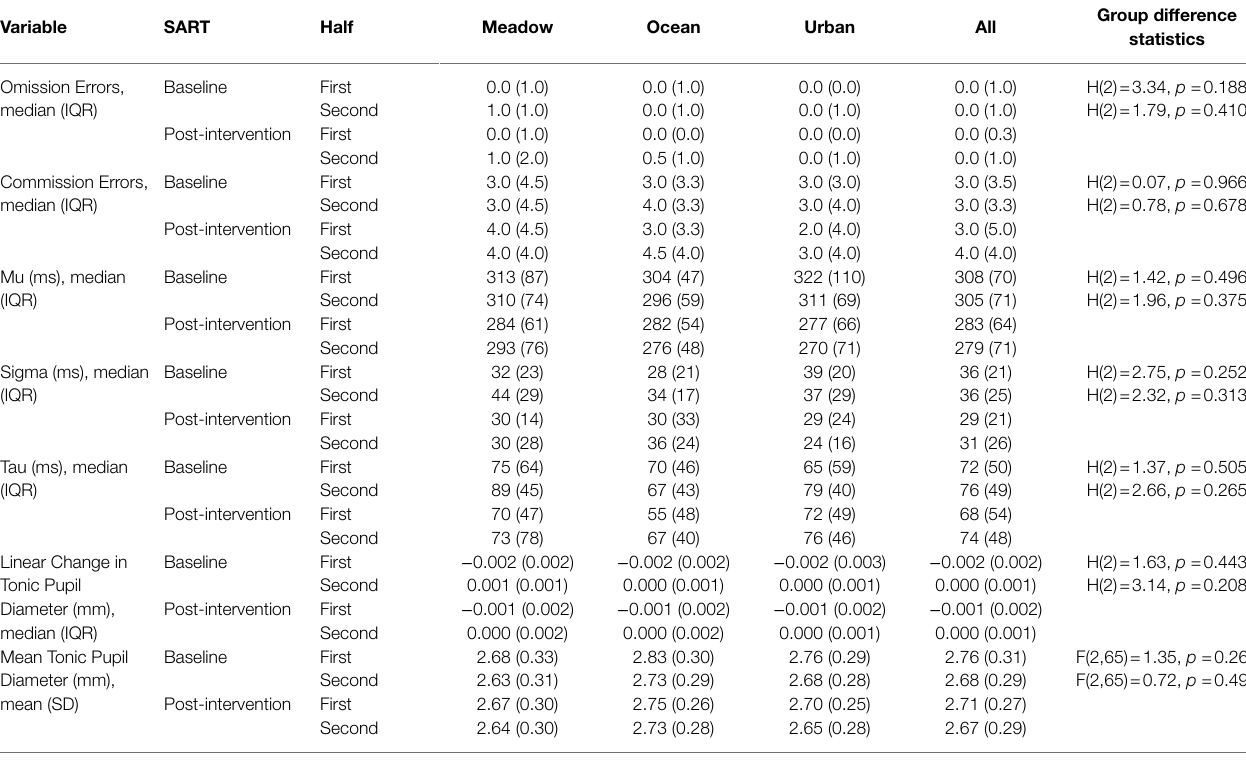
TABLE 2 | Descriptive statistics for each group for the SART and pupillometry variables for Study 1. Variable SART Half Meadow